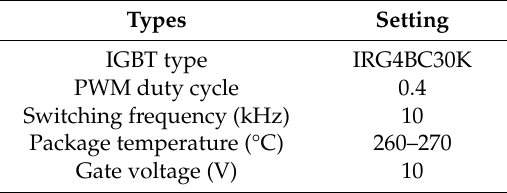
Table 2. Accelerated aging test parameters.